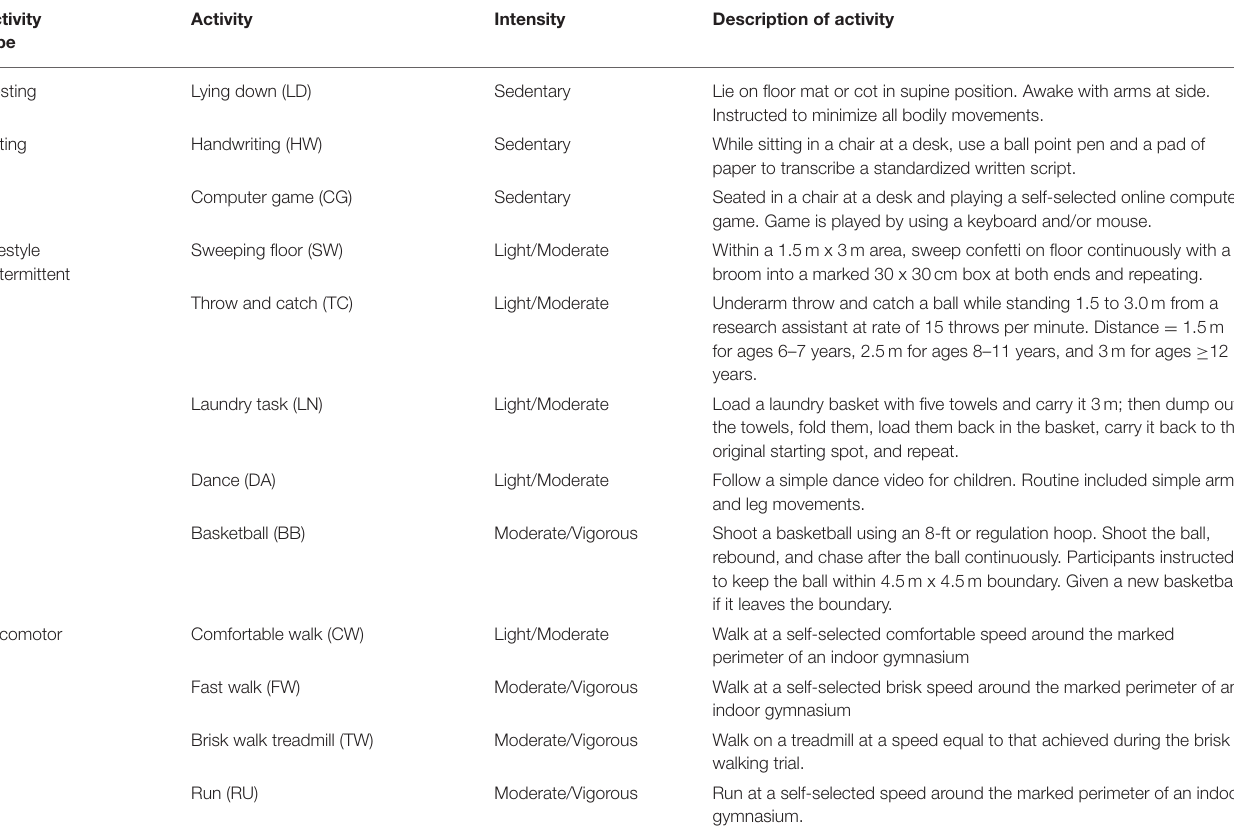
TABLE 2 | Description of the 12 structured activities. Activity